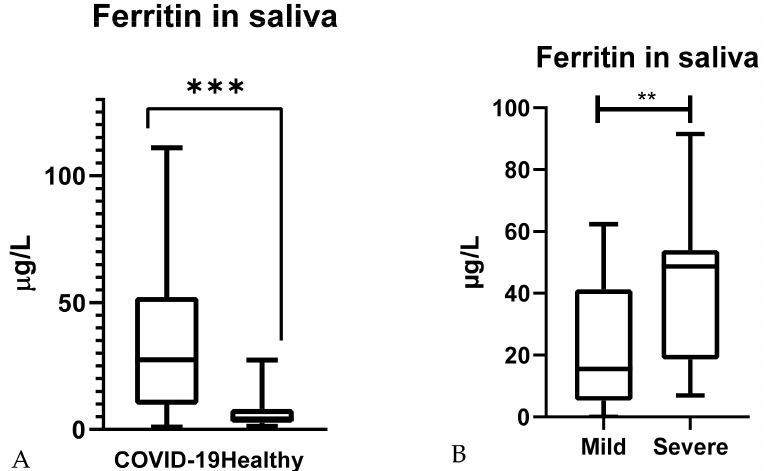
Figure 1. ( A ) Ferritin in saliva concentration in healthy individuals and COVID-19